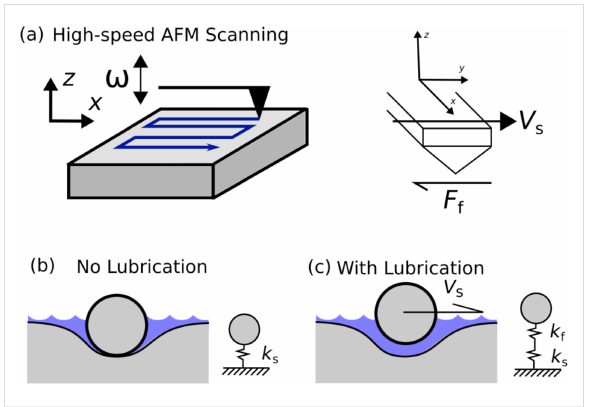
Figure 1: Hydrodynamic lubrication phenomenon. (a) The AFM tip is in intimate contact with the sample surface oscillating with a frequency ω , scanned at a fixed velocity V s , and experiencing frictional forces F f . (b) The stiffness detected by the AFM probe is represented solely by the sample stiffness k s . (c) At a critical velocity, a thin film of supportive water forms between the AFM tip and sample. The stiffness detected by the AFM probe is now represented by the series summation of the water film stiffness k f and the sample stiffness k s